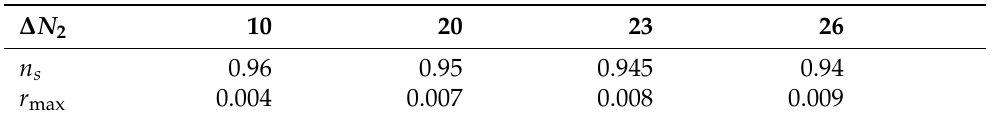
Table 2. The approximate values of n s and r for some choices of ∆ N 2 after tuning the parameter ζ around its inflection point